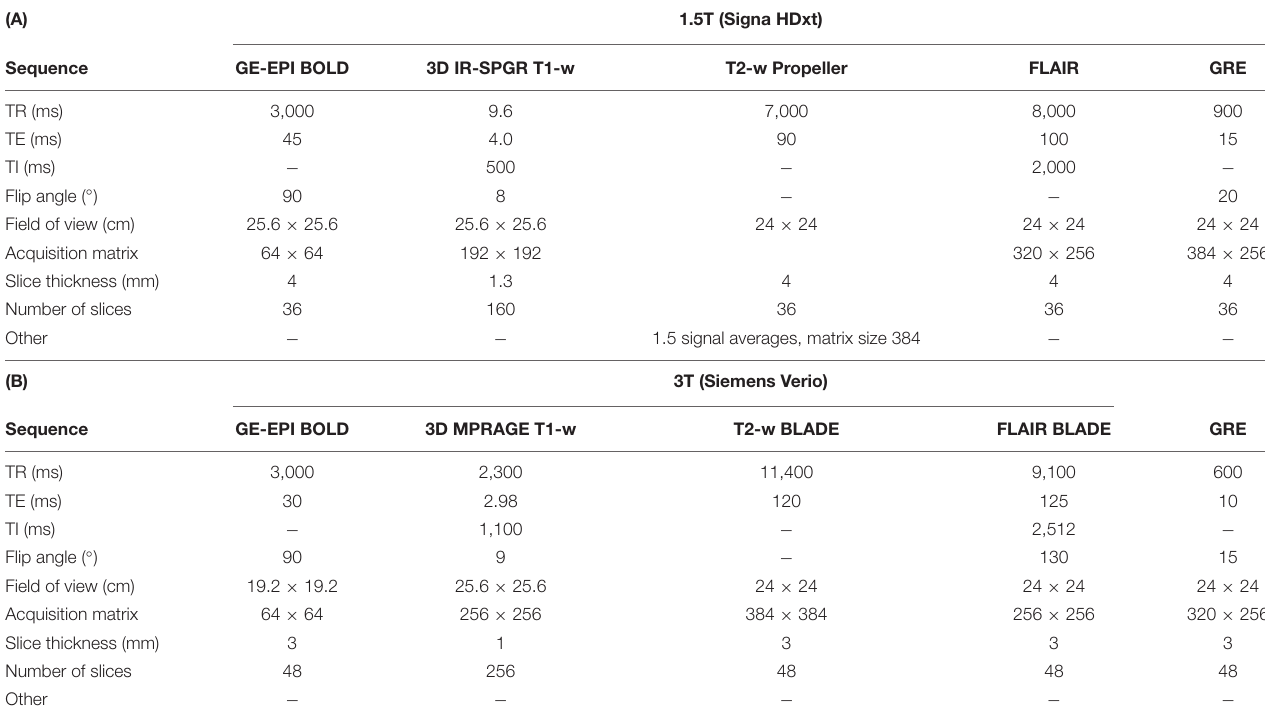
TABLE 1 | MR sequence parameters used for (A) 1.5T and (B) 3T imaging